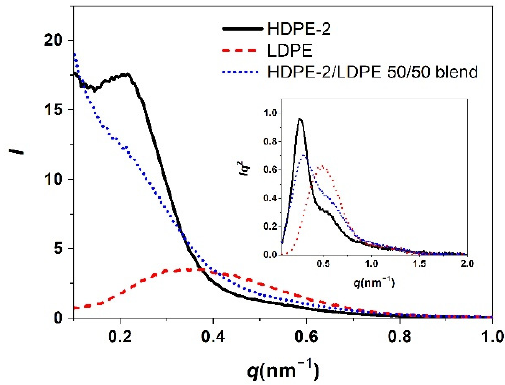
Figure 6. The linear and Lorentz-corrected SAXS profiles of the neat HDPE-2, neat LDPE, and the HDPE-2/LDPE blend.